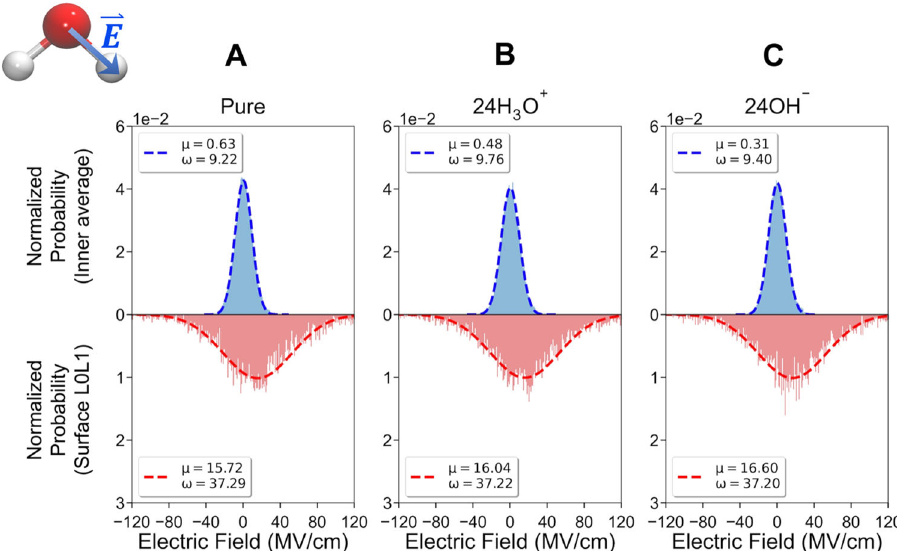
Fig. 4 Electric fi eld distributions arising from electric fi eld projections on the O – H bonds of water . The hydrogen-bonded water molecules in the inner droplet region (blue) and the surface free O – H water bonds (red) for the R40 droplet with ( A ) pure water, water with ( B ) 24 H 3 O + and ( C ) 24 OH −